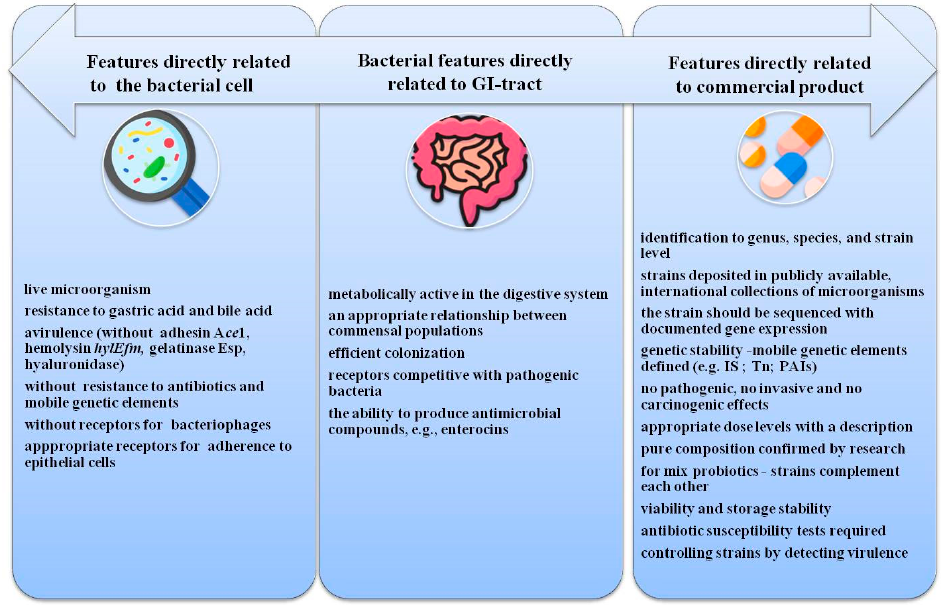
Figure 1. Required features of Enterococcus spp. in relation to probiotics.